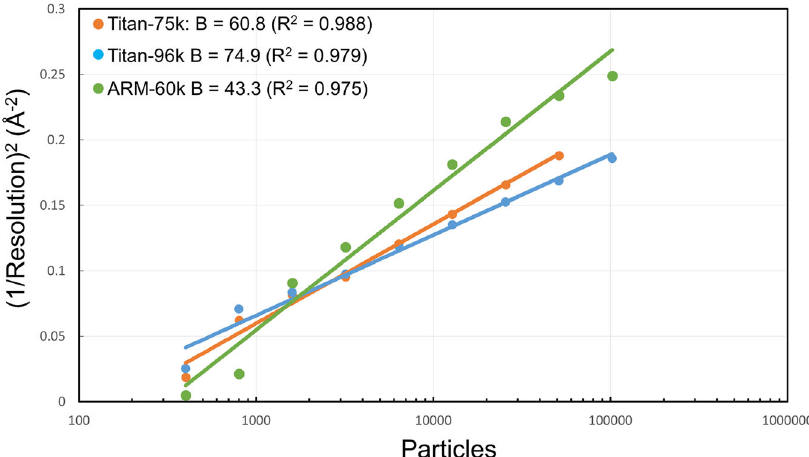
Fig. 1 B-factor plot for the datasets of Titan-75k, Titan-96k, and ARM-60k. B-factor plot for the Titan-75k dataset at a dose of 40 e − Å − 2 (blue), the Titan-96k dataset at a dose of 40 e − Å − 2 (orange), and the ARM-60k dataset at a dose of 83 e − Å − 2 (green).